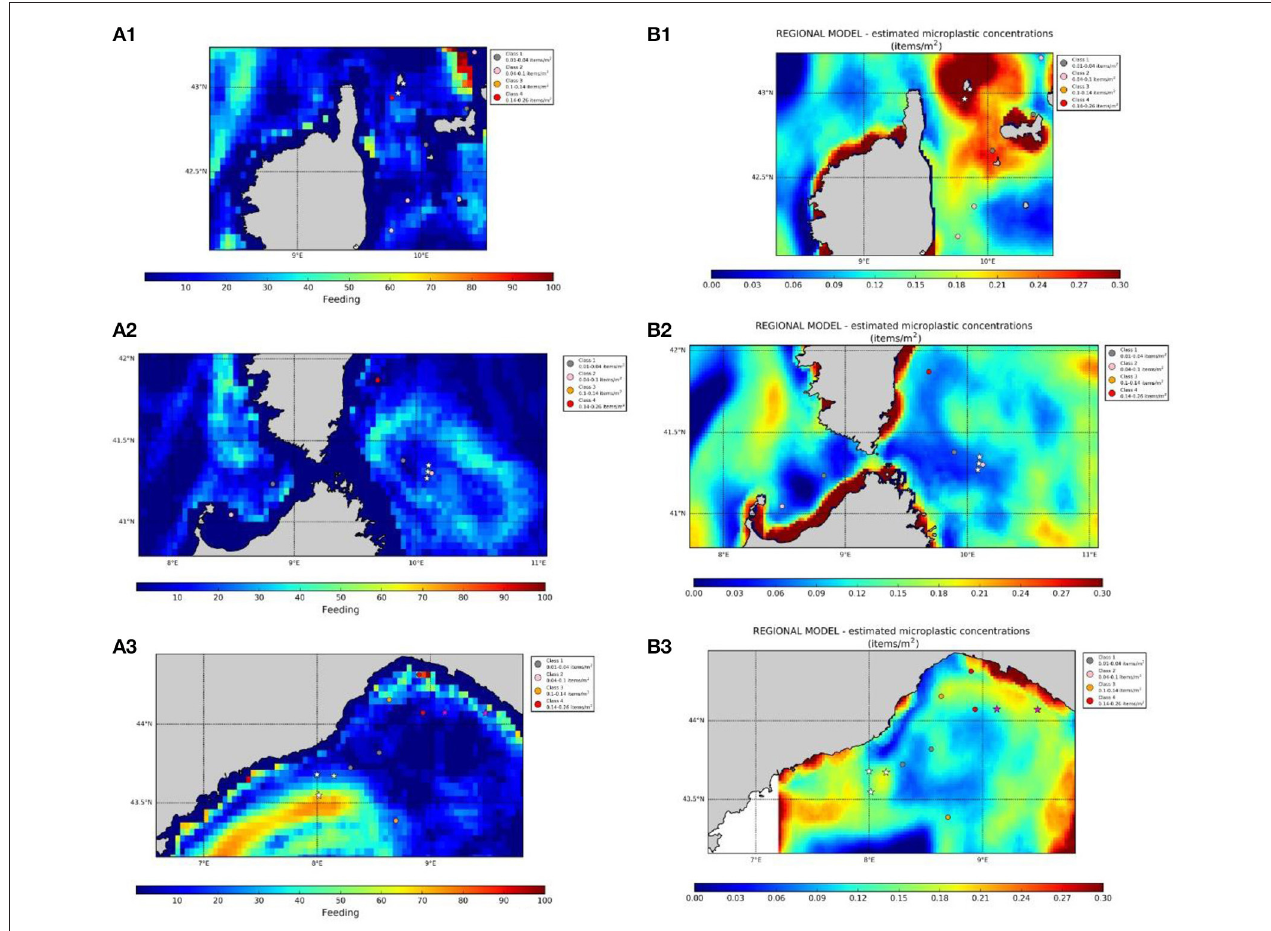
FIGURE 9 | Fin whale habitat maps (Feeding Habitat Occurrence) (A1–A3) and simulated distribution of microplastics (items/m2) (B1–B3) in north-western Mediterranean Sea. Microplastic concentrations (circle), and cetacean sighting data (white star: Balaenoptera physalus , pink star: Stenella coeruleolba , Tursiops truncatus , Grampus griseus ) plotted in the two maps. Maps were produced using Matlab software (Release 14) and Python 2.7.12 for Linux